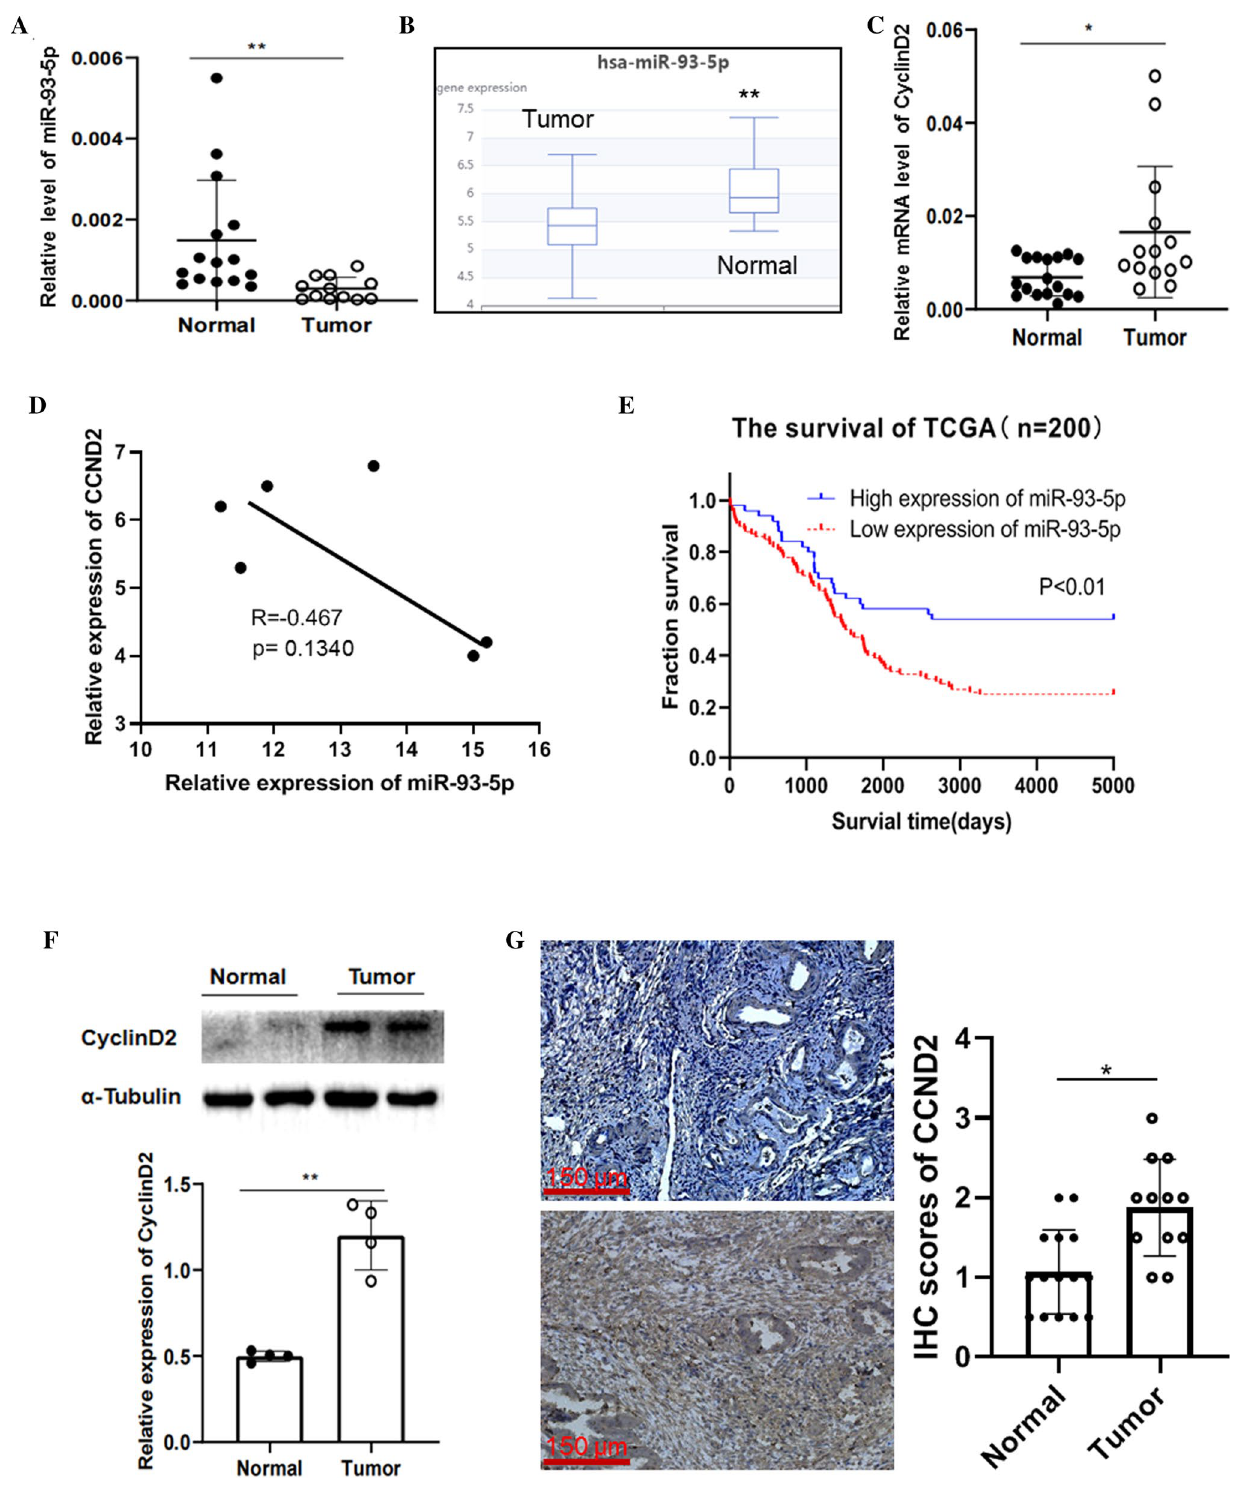
Fig. 4 miR-93-5p is downregulated in ovarian cancer and predicate good outcome of patients. A The qPCR was applied to measure the expression of miR-93-5p in ovarian cancer tissues and normal ovary tissues (**P < 0.01). B The expression of miR-93-5p in ovarian tumor and normal health indi- vidual were extracted from the dbDEMC database (Experiment ID, EXP00625, **P < 0.01). C The qPCR was employed to measure the expression of CCND2 in ovarian cancer tissues and normal ovary tissues (*P < 0.05). D The Pearson analysis was performed to mRNA of CCND2 and miR-93-5p in tumor tissues. E The survival data and miR93-5p data were extracted from TCGA database and Kaplan–Meier Plotter analysis was performed (**P < 0.01). F Western blot were carried out to measure the CCND2 protein level in ovarian tumor tissues and normal ovary tissues (**P < 0.01). G IHC experiment was applied to detect the CCND2 in ovarian cancer tissue and normal ovary tissues, Scale bar = 150 μm (*P <